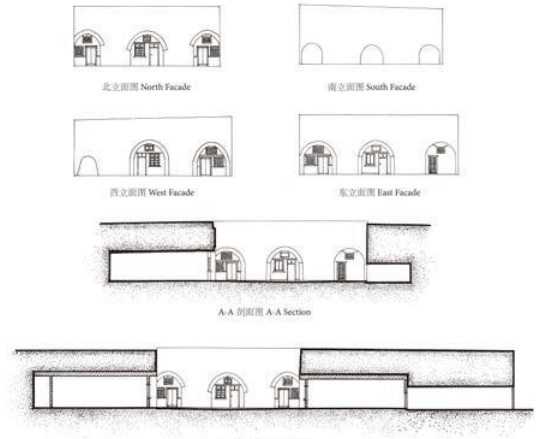
Figure 12. Architectural drawings of No7 sunken cave dwelling. Caves on the east side of the courtyard are the deepest found in the two villages. Cave distribution among a family: Caves in